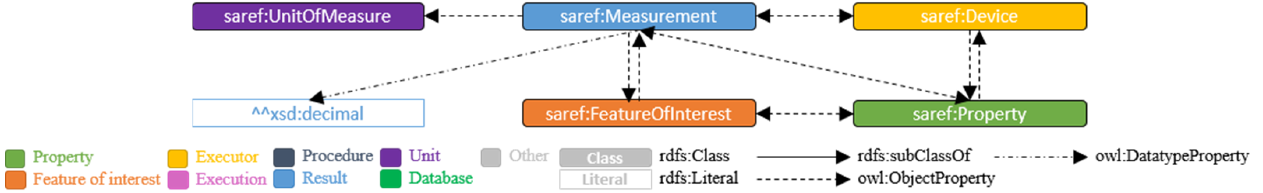
Figure 13. Redundant classes in the Fiesta-IoT pattern.